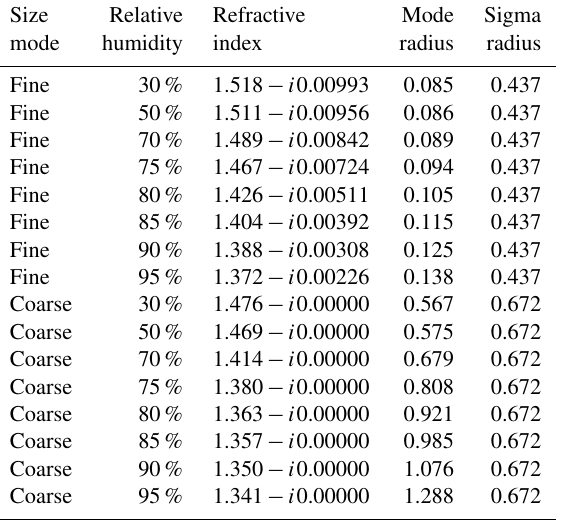
Table 1. Optical properties for the aerosol models used in radiative transfer calculations, from Ahmad et al. (2010). Note that refrac- tive indices are specified for 865nm. In the radiative transfer cal- culations, the fine- and coarse-mode microphysical properties are combined at one of 10 different volume concentrations, where the fine mode contributes 0%, 1%, 2%, 5%, 10%, 20%, 30%, 50%, 80%, or 95%. Mode radius is specified in micrometers, and size distributions are lognormally distributed.